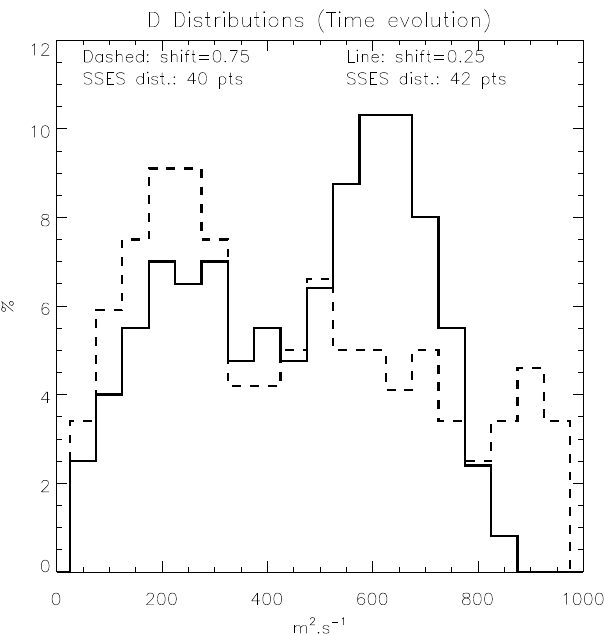
Fig. 6. D distributions in the first (bold line) and second (dashed line) halves of the event.